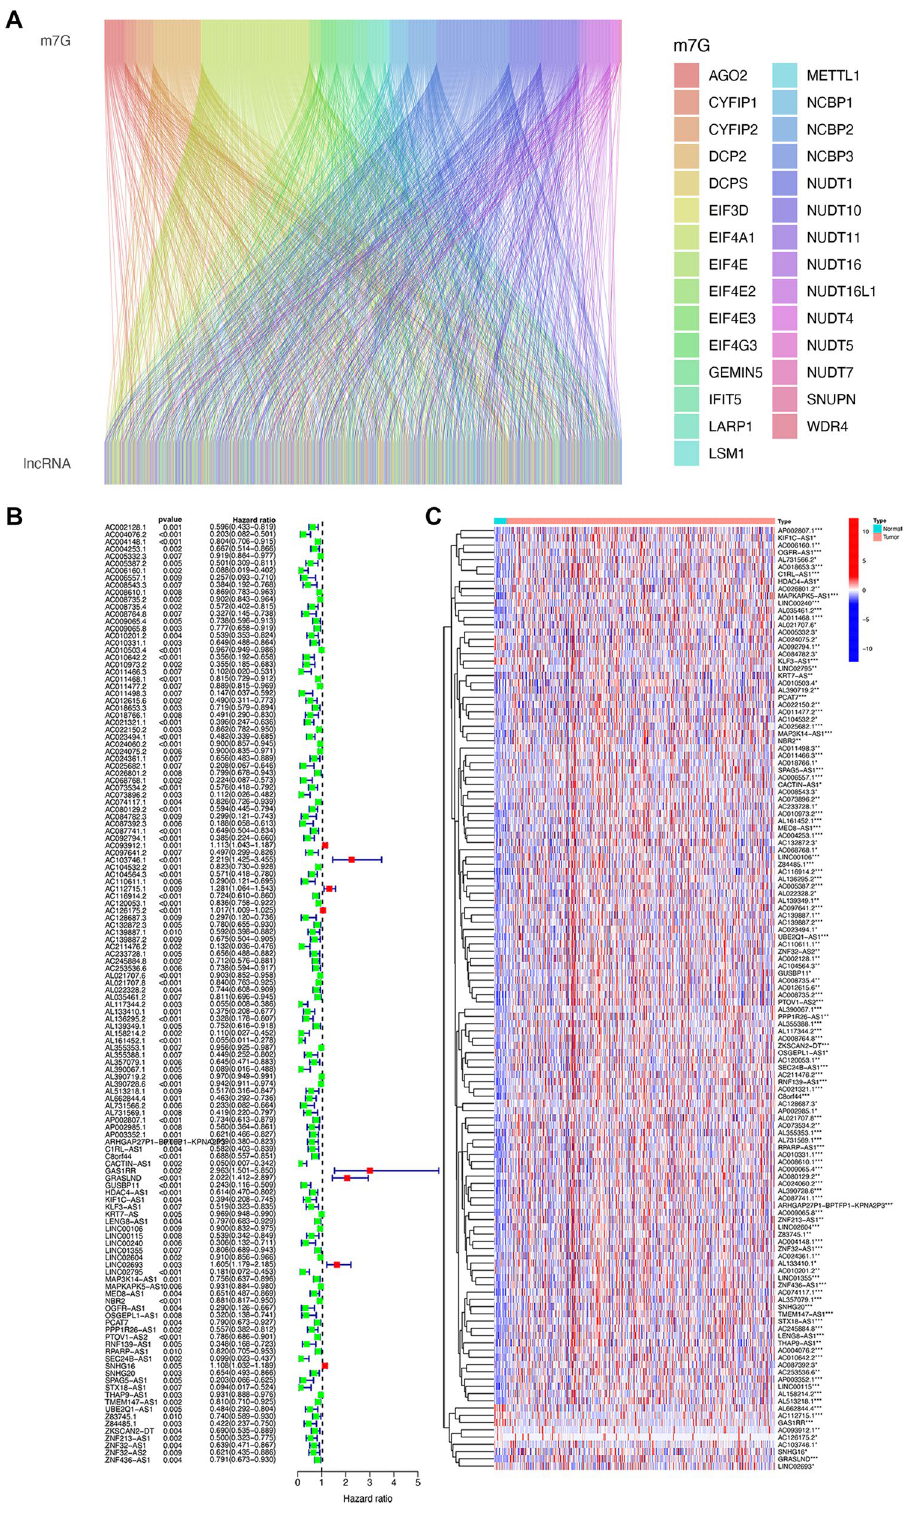
Figure 2. Identification of m7G-ralated prognostic lncRNAs. ( A ) Sankey diagram showing that correlation between m7G-related genes and lncRNAs. ( B ) Forest plot of the univariate Cox regression analysis between the 130 m7G-related lncRNAs and overall survival (OS) in BC patients. ( C ) Heatmap of differently expressed m7G- related lncRNAs between tumor and normal issues. The heatmap was created by using “pheatmap” package in R 4.2.1 (https:// www.r- proje ct. org/). * P < 0.05; ** P < 0.01; *** P <